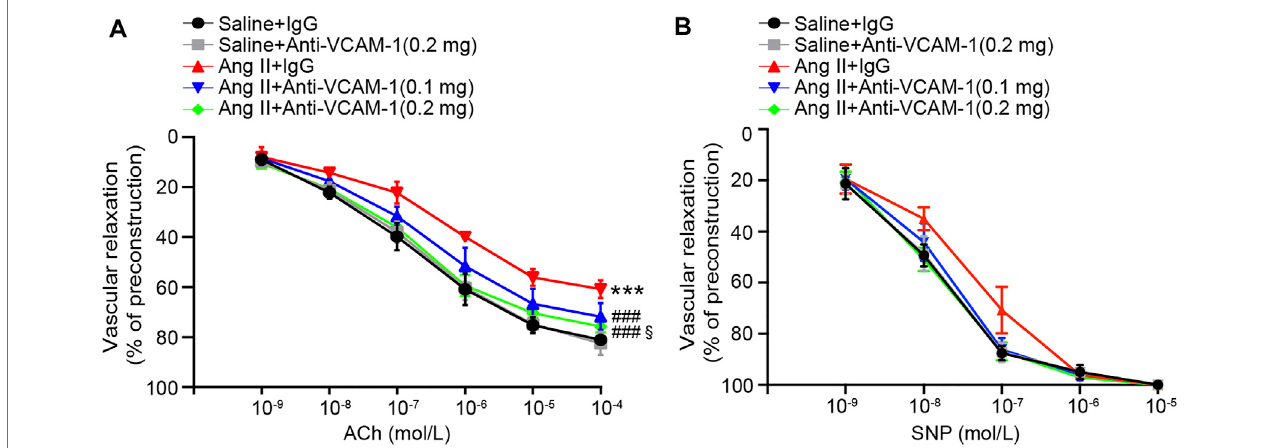
FIGURE4| BlockadeofVCAM-1amelioratesAngII-inducedvasculardysfunction. (A) WTmiceweretreatedwithaVCAM-1neutralizingantibody(0.1and0.2 mg/ mouse) or IgGcontrol and infused with Ang II(490 ng kg − 1 min − 1 ) or saline for 14 days. Analysis ofendothelium-dependent vasodilation ofthe aorta in responseto ACh ( n = 6). (B) Analysis of endothelium-independent vasodilation of the aorta in response to SNP ( n = 6). The data are expressed as the mean ± SD, and n represents the number of samples. *** p < 0.001 versus saline; ### p < 0.001 versus Ang II + IgG; § p < 0.05 versus Ang II + anti-VCAM-1 (0.1 mg).